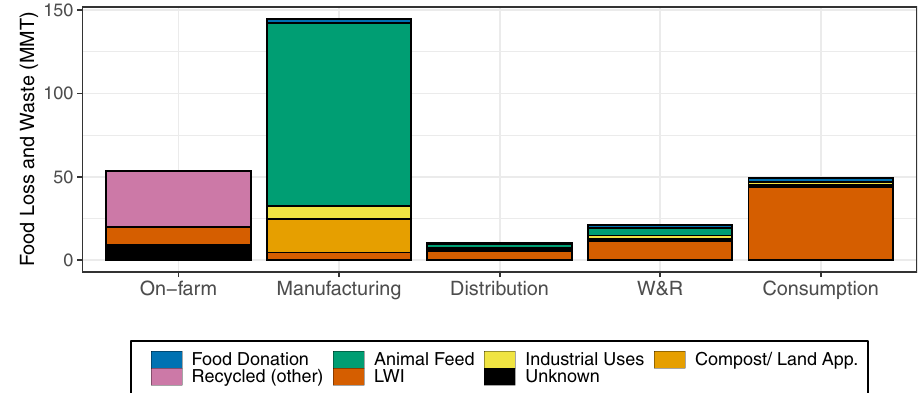
Fig. 5 FLW management pathways along the FSC. Breakdown of FLW by FLW management pathway for each FSC stage: on-farm, manufacturing, distribution, wholesale and retail (W&R), and consumption. The pathways remain in the same order in each column (if used within the stage), relating to the EPA ’ food recovery hierarchy: food donation (purple-pink), animal feed (green), industrial uses (yellow), compost or land application (orange), recycled (other) is speci fi cally for crop-based on-farm FLW recycled using unknown methods, LWI (vermillion) represents disposal via land fi ll, wastewater treatment, and incineration, unknown (black) represents animal-based on-farm FLW disposed via unknown